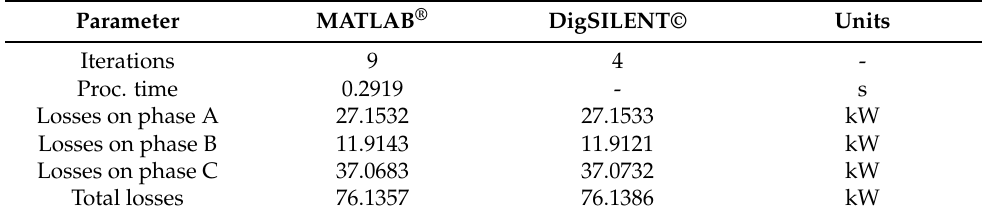
Table 9. Numerical results for the IEEE 37-node test